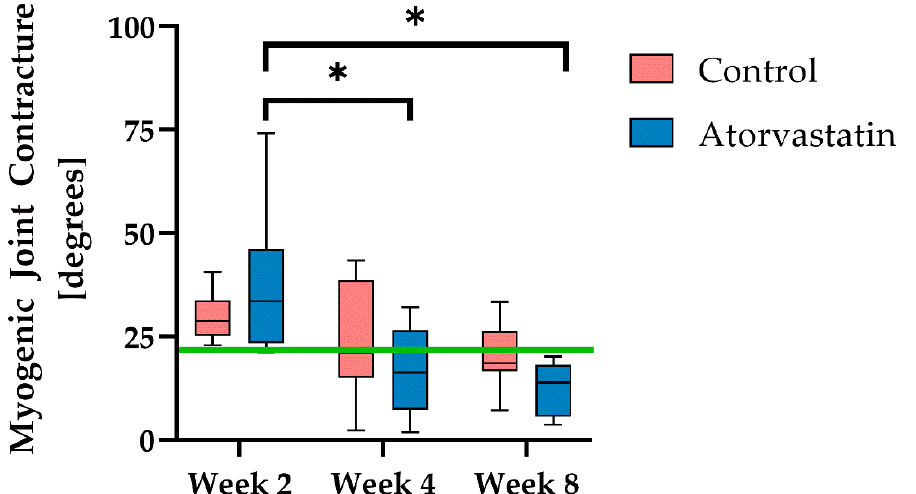
Figure 4. Myogenic joint contracture at weeks 2, 4 (immobilization) and 8 (remobilization); n = 8 per group and time point, and n = 7 only in control after 8 weeks. Data are presented as boxplots with median, minimum and maximum. The green line represents the physiological muscular inhibition of joint extension in rats. Significant differences ( p < 0.01) are marked with *.